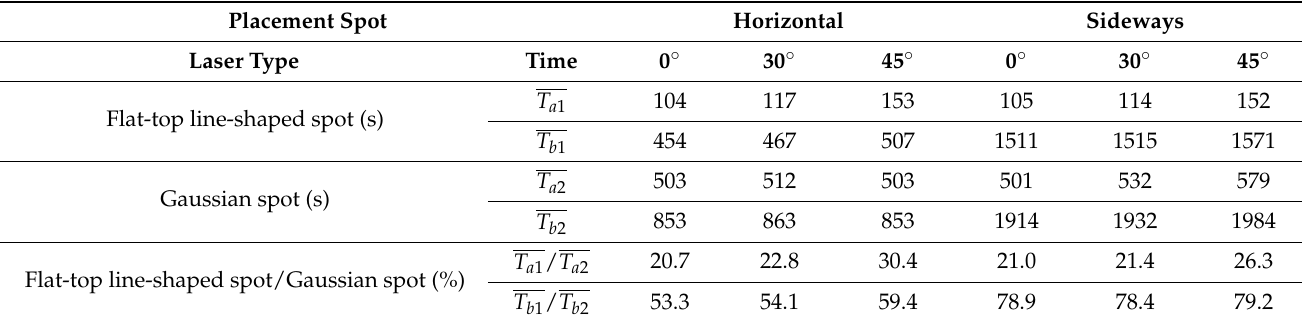
Table 8. Molding data of sample